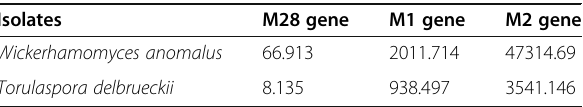
Table 5 The fold change of three genes for Wickerhamomyces anomalus and Torulaspora delbrueckii Isolates